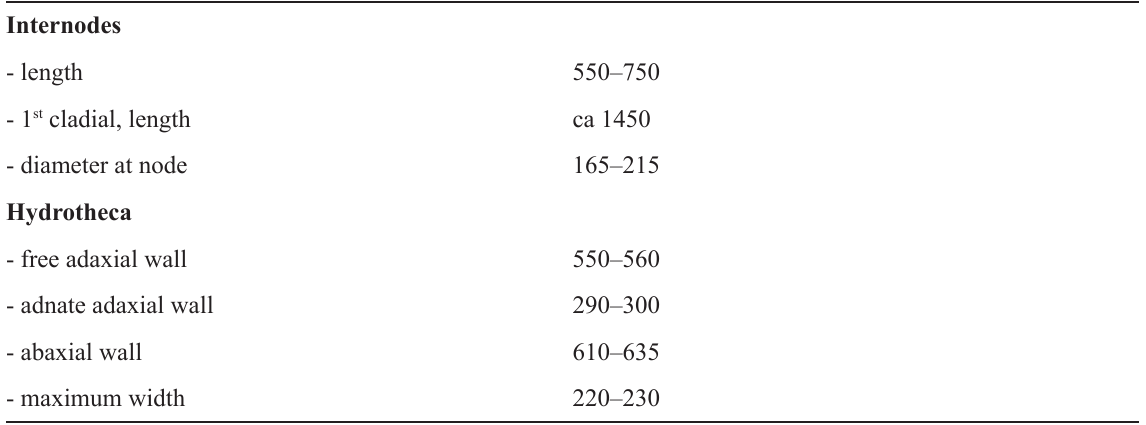
Table 5. Measurements of Diphasia alternata Galea, sp. nov., in µm.